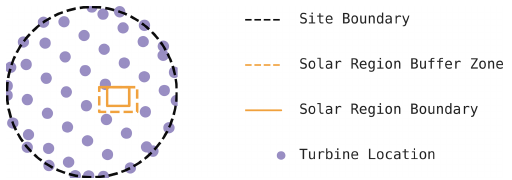
Figure 1. An example layout of a wind–solar hybrid power plant inside a circular site